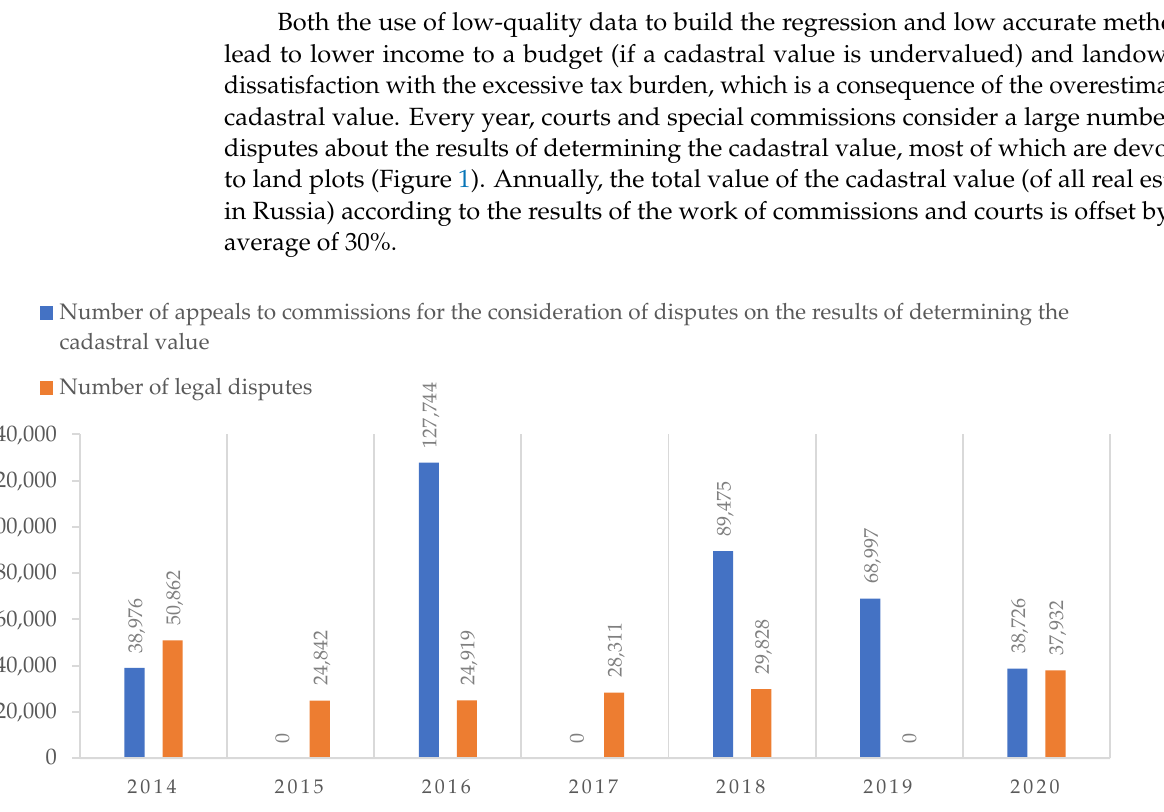
Figure 1. Statistics of appeals to commissions for the consideration of disputes on the results of determining the cadastral value and legal disputes. Source: Federal Service for Registration, Cadastre, and Cartography.